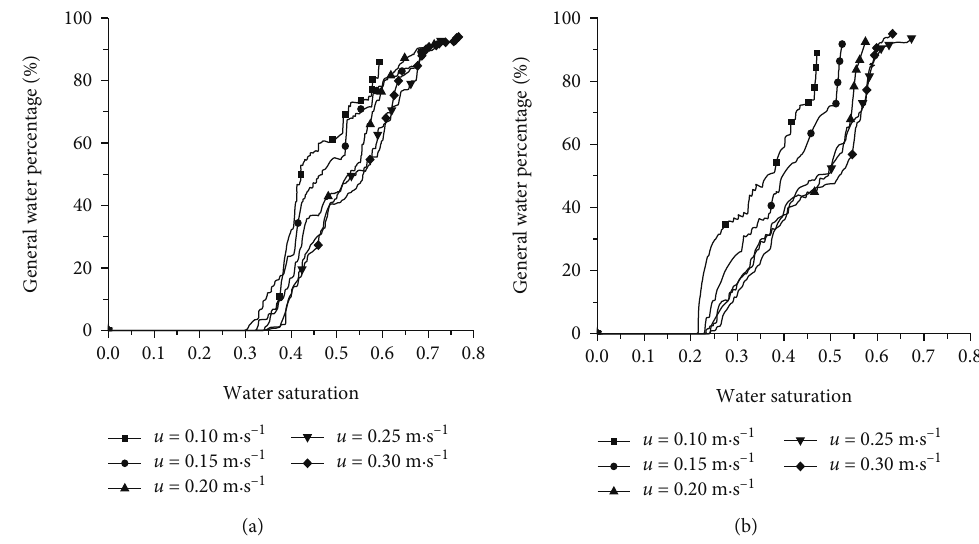
Figure 2: Water fl ooding curve at di ff erent injection velocity: (a) contact angle θ = 25 ° ; (b) contact angle θ = 165 ° .